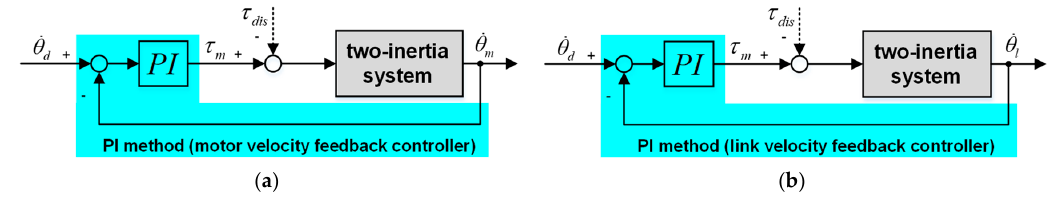
Figure 8. Block diagram of PI method: ( a ) based on motor velocity feedback; ( b ) based on link velocity feedback.